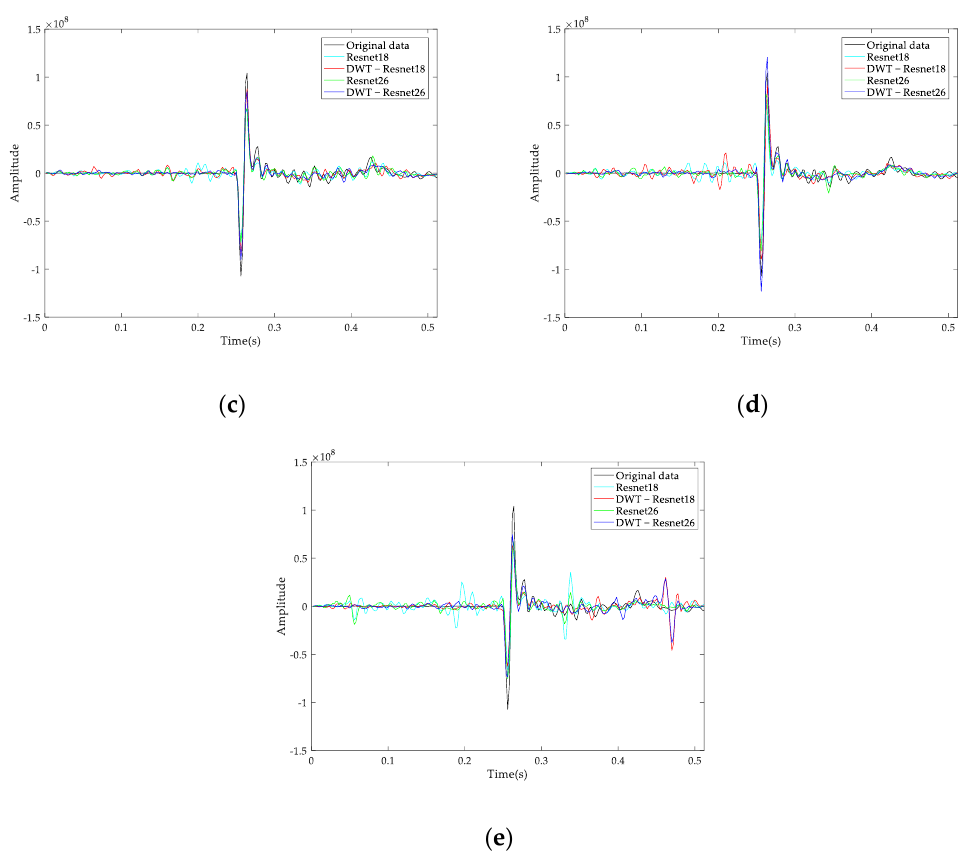
Figure 11. ( a – e ) Illustrates the single − channel real data compared with the original single − channel real data after denoising with four denoising methods at SNRs ranked from high to low.